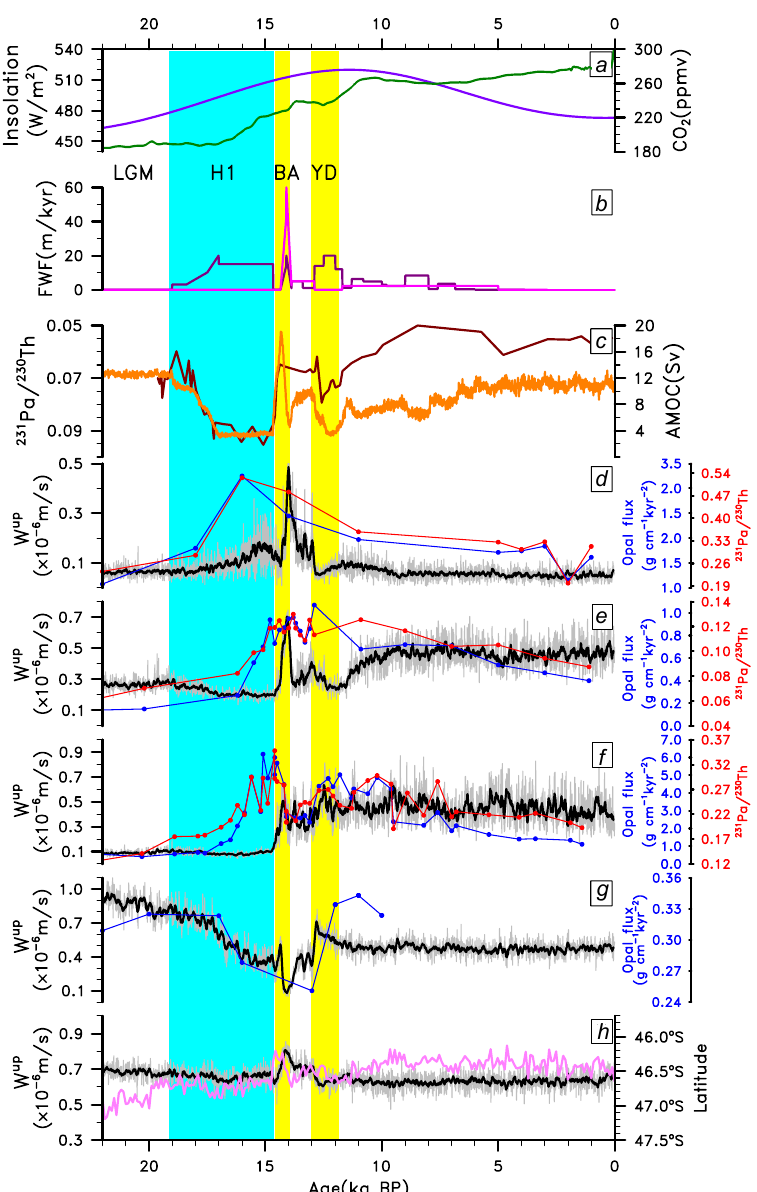
Figure 1. ( a ) June insolation at 60 ◦ N (purple) [45] and atmospheric CO 2 concentration (green) [46]; ppmv, parts per million by volume. ( b ) Freshwater fluxes (FWF) in the Northern (dark pink) and Southern (light pink) Hemispheres in TraCE-21ka. ( c ) The 231 Pa/ 230 Th ratio (brown) at Bermuda (GGC5 core) as a proxy for AMOC export [47], and model maximum AMOC transport (below 500 m, orange). ( d – h ) The column integrated upwelling (gray) and its 100-year average (black) in TraCE-21ka at corresponding grids of proxy cores ( d ) A, ( e ) B, ( f ) C and ( g ) D, and ( h ) averaged over the ACC region. In these panels, opal fluxes (blue) and initial unsupported 231 Pa/ 230 Th ratio (red) are reproduced from previous studies [2,32]. In ( h ), the maximum of the 100-year mean Southern Hemisphere westerlies on 867 hpa is shown in orchid. As the shift of the westerlies could be small and within a grid of the atmosphere model, a quadratic interpolation around the grid point with maximum mean wind is adopted to yield the exact latitude of the mean jet [25]. H1: Heinrich event 1; BA: Bølling–Allerød; YD: Younger